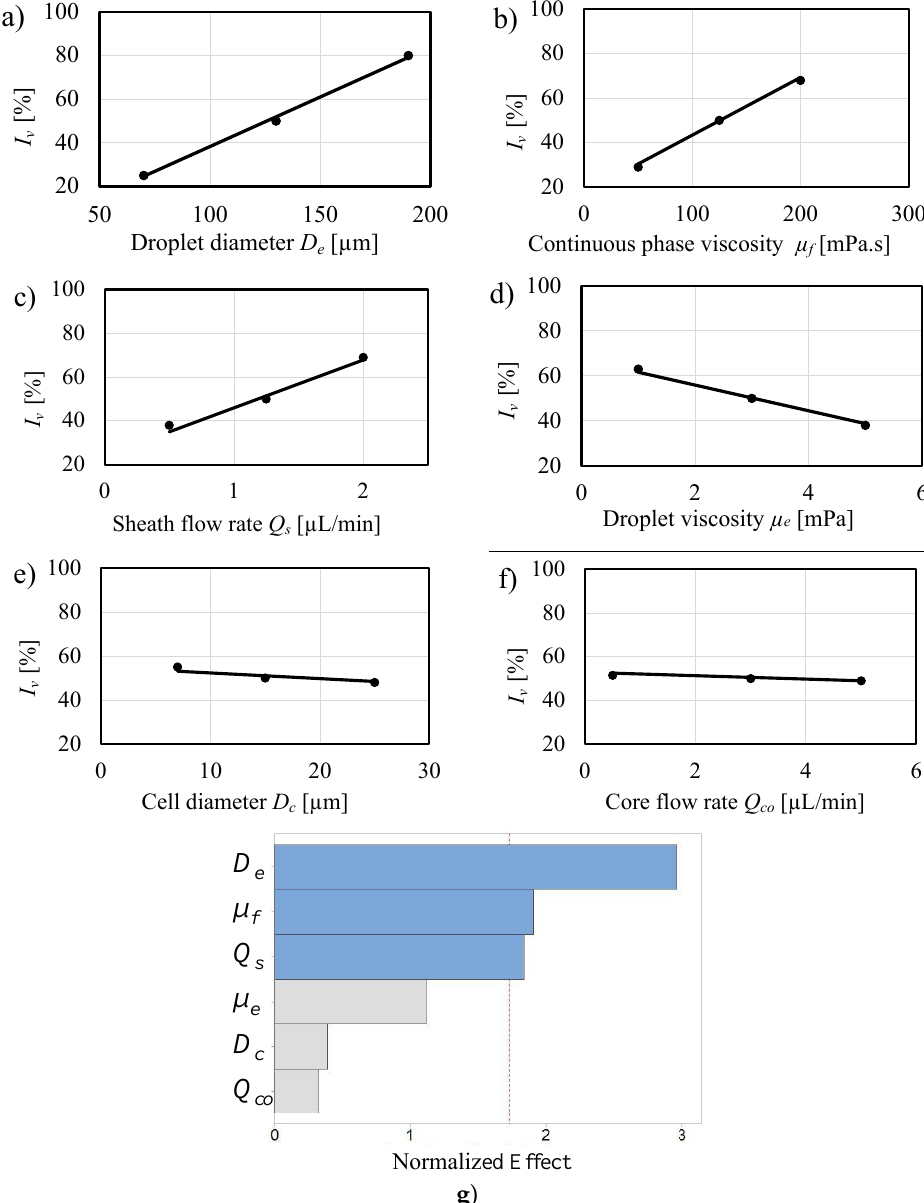
Figure 5. Effect of various microfluidic and cell related parameters on the rotational flow field: ( a ) Effect of D e on I v , ( b ) Effect of µ f on I v , ( c ) Effect of Q s on I v , ( d ) Effect of µ e on I v , ( e ) Effect of D c on I v , ( f ) Effect of Q co on I v , ( g ) Pareto chart with parameters sorted in the order of